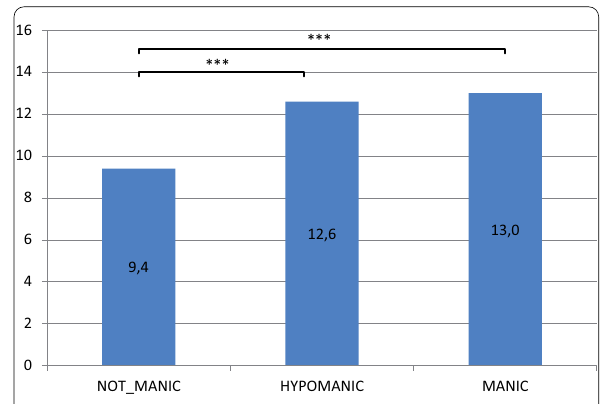
Fig. 3 Average IDS-C-Symptom count by state (based on 4-item YMRS core-score), EVEN sample. ***p <